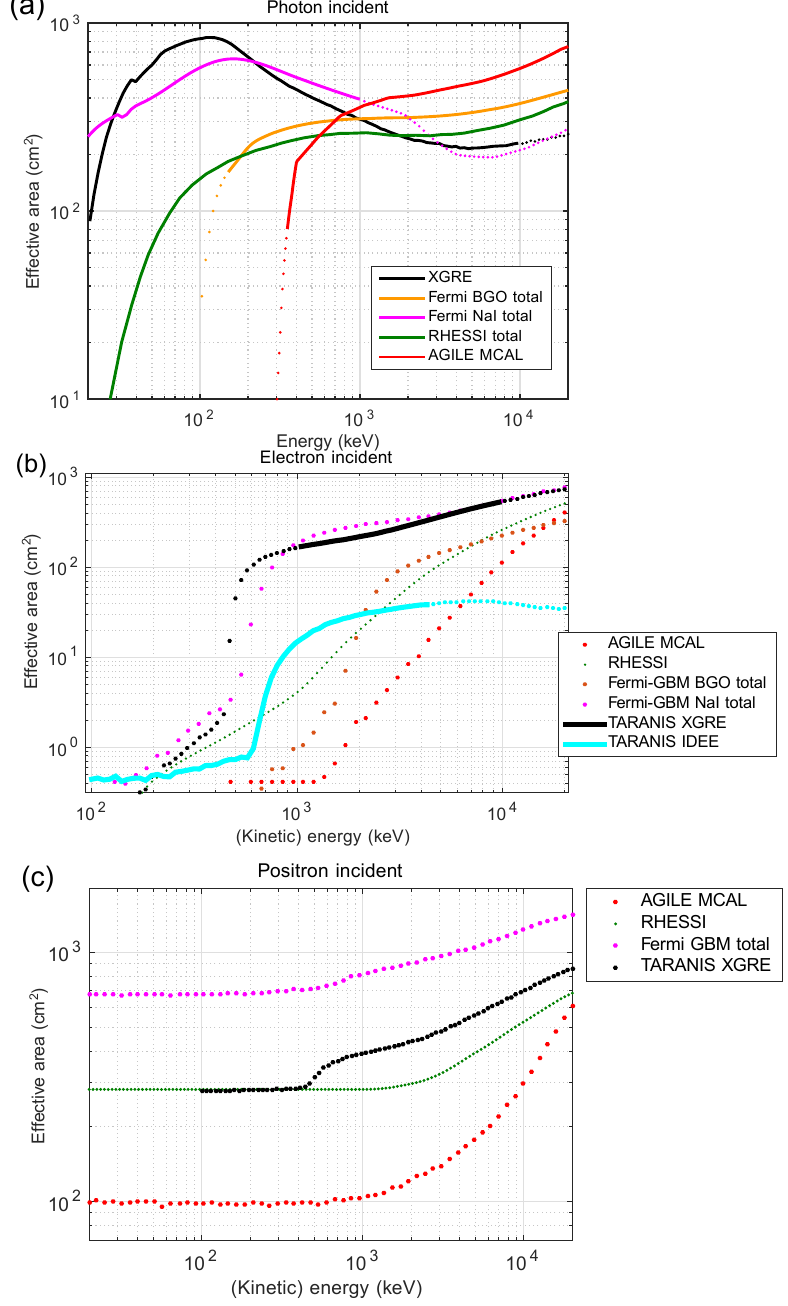
Figure 2. (a) Effective area for X-rays and gamma rays vs. energy for the considered detectors. (b) Effective area for electrons vs. energy for the considered detectors. (c) Effective area for positrons vs. energy for the considered detectors. A full line indicates that the spectroscopy is possible at the given energy, and a dot line indicates that it is not. TARANIS XGRE and IDEE data come from GEANT4 simulations performed for this work. Concerning photon response (a) , the data for Fermi-GBM were obtained by averaging about 100 response matrices generated from publicly available tools provided by the Fermi-GBM collaboration. For RHESSI, the data were extracted from the response matrix provided by D. Smith. For AGILE-MCAL, this data are reproduced from literature. Concerning the response to electrons and positrons ( b and c ), these results are obtained from GEANT4 and GEANT3 simulations using the mass models of the spacecrafts (or an approximative version for Fermi). Complete references are presented in the code and data availability